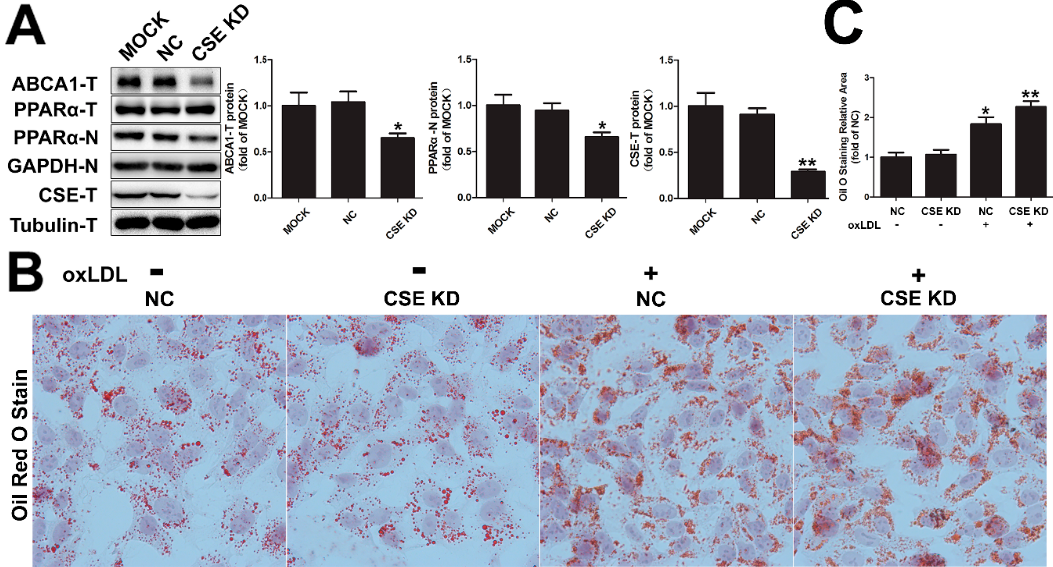
Figure 5. Effect of cystathionine γ -lyase-specific small interfering RNA (CSE-siRNA) on PPAR α - meditated ABCA1 expression and lipid accumulation. ( A ) HepG2 cells were transfected without siRNA (MOCK), or with the negative control (NC) or CSE siRNA (CSE KD) for 48 h, total proteins and nuclear proteins were prepared, followed by Western blotting with the indicated antibodies. T: total, N: nuclear. n = 3, * p < 0.05 and ** p < 0.01 vs. MOCK; ( B ) HepG2 cells were pretreated with negative control siRNA and CSE siRNA for 24 h, followed by treatment of oxLDL (25 μ g/mL) for another 24 h, Scale bar = 20 μ m. After incubation, cells were fixed and stained with Oil Red O, and the representative images were shown; ( C ) The areas of positive Oil Red O staining were calculated with ImageJ software (* p < 0.01 ** p < 0.05 vs. NC group).